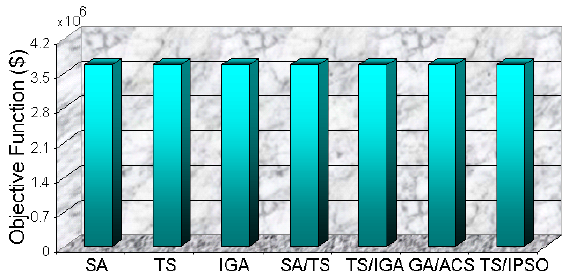
Figure 7. Comparison of the proposed algorithm with other modern algorithms in case 1.